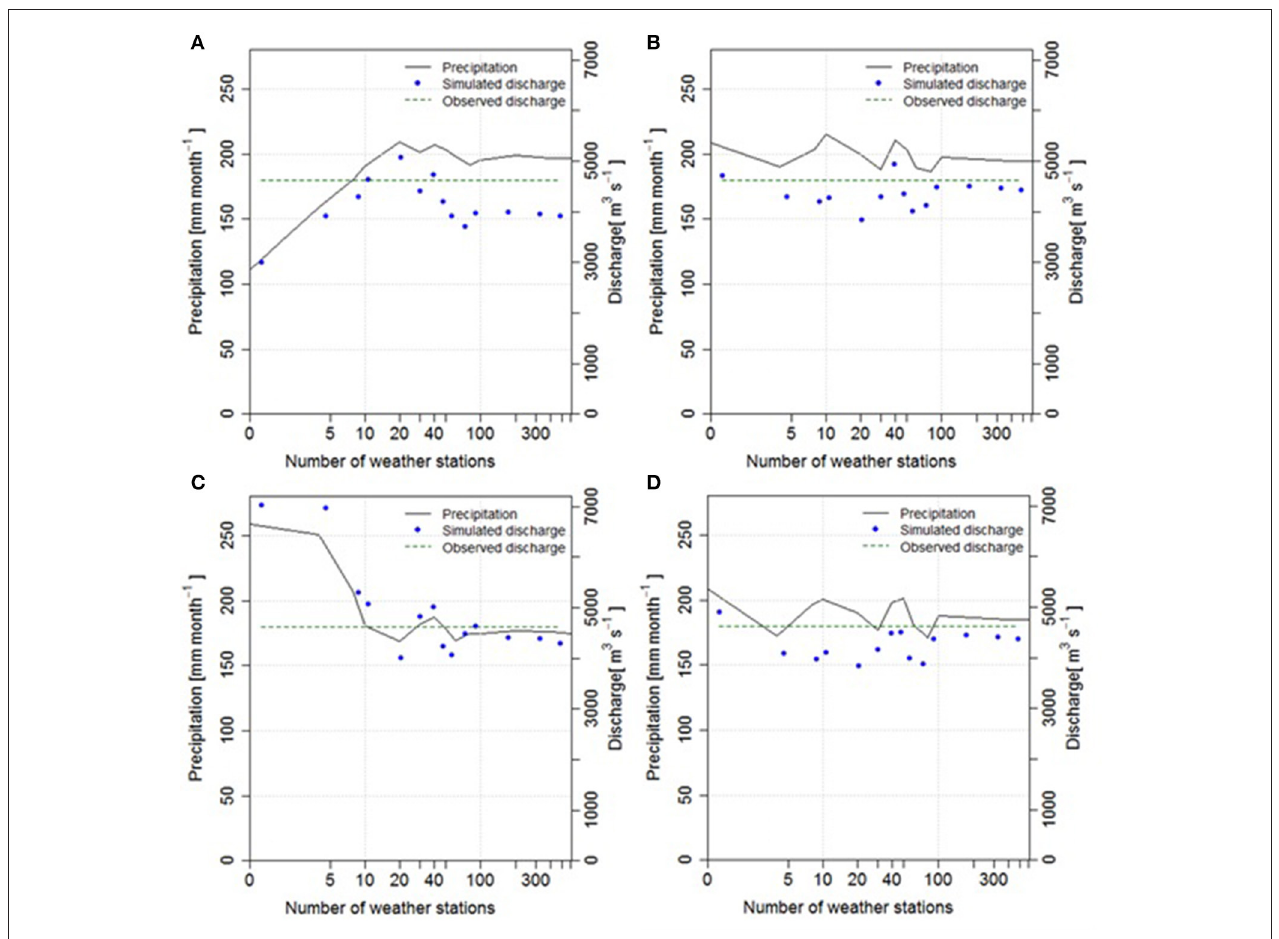
FIGURE 9 | Monthly areal average precipitation (left vertical axis) and simulated (blue dots) and observed (green dashed line) average discharge (right vertical axis) at Barbosa station (25027530) at 1km resolution for the 2000–2012 period, derived with different number of weather stations (0, 4, 8, 10, 20, 30, 40, 50, 60, 80, 100, 200, 400, and 616). (A) CMORPH, (B) MSWEP, (C) PERSIANN, and (D) TRMM. Logarithmic scale was used for the horizontal